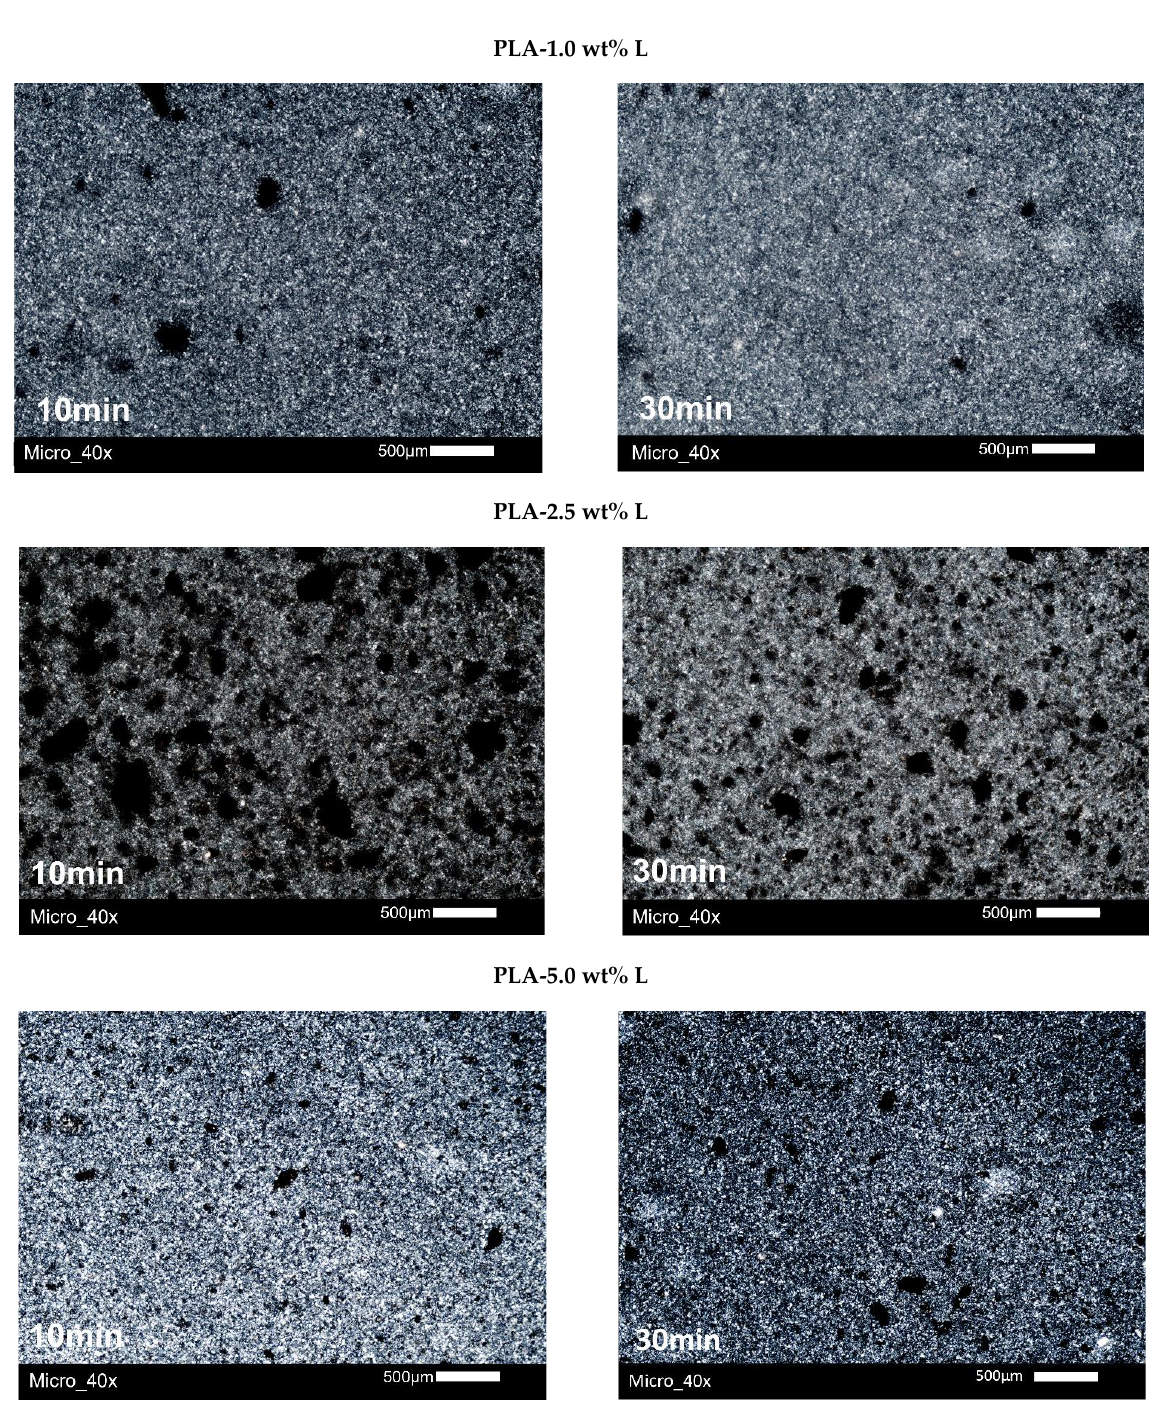
Figure 9. Microphotographs of neat PLA and PLA – lignin composites after annealing for 10 and 30 min using PLM.